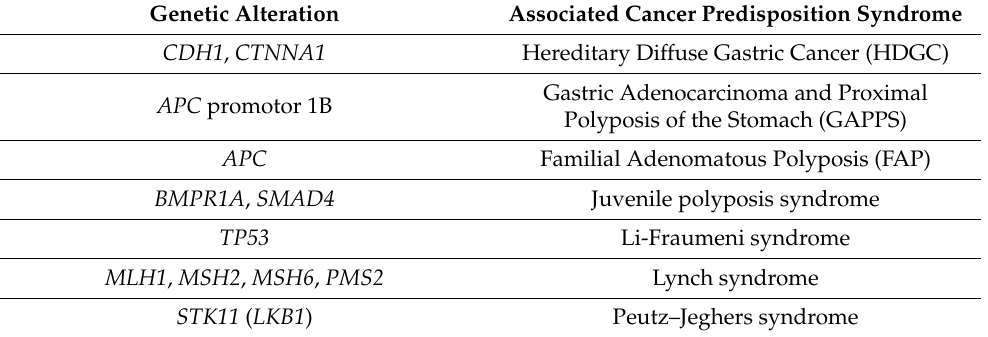
Table 6. Overview of cancer predisposition syndromes associated with gastric carcinoma and the respective underlying genetic alterations